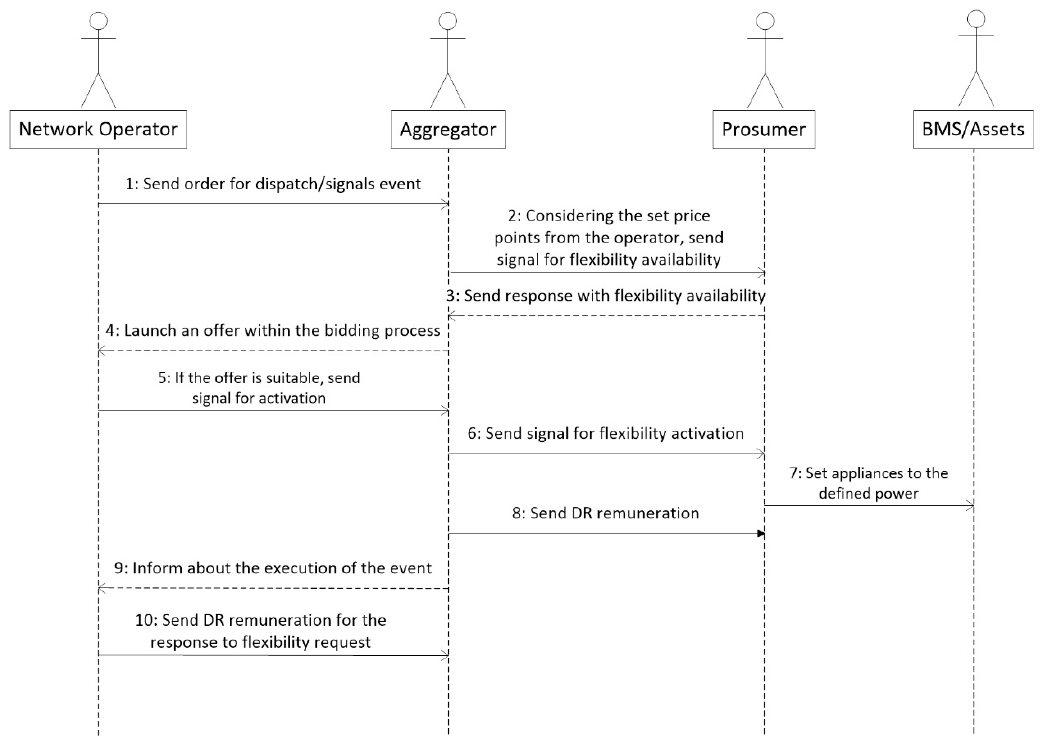
Figure 3. Demand Reduction Bidding Sequence of Interactions diagram.